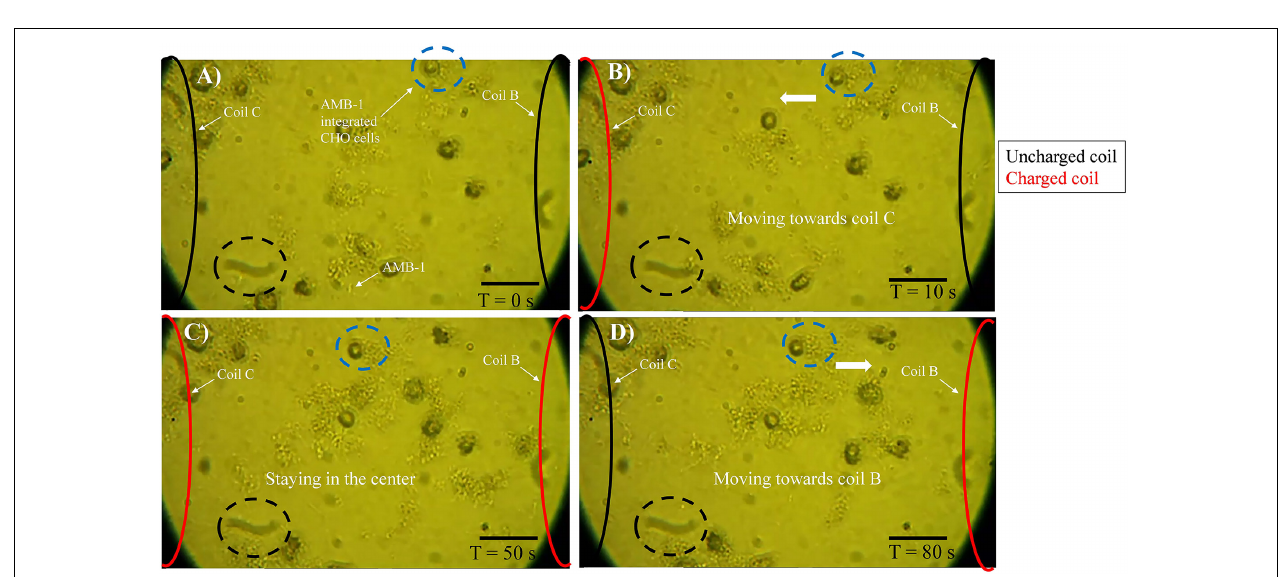
FIGURE 1 | Schematic illustrating the experimental setup for directional control displaying the movement of AMB-1-integrated CHO cells from coil A to coil C. The charged coil is showed in red, and the AMB-1-integrated CHO cells are displayed as blue dots.